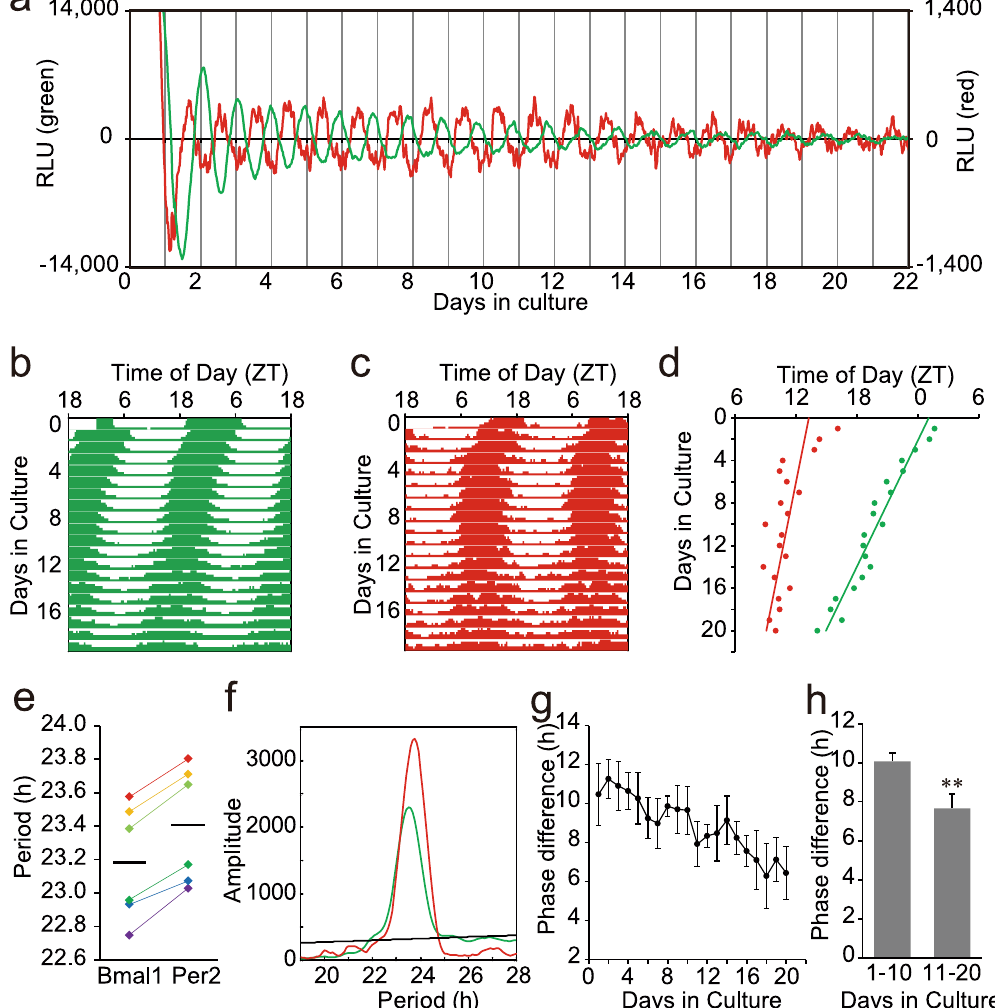
Figure 1. Circadian rhythms in the neonatal SCN slices of Bmal1-Eluc:Per2-SLR2 mice ( a ) Sequential records of circadian Bmal1 (green) and Per2 (red) rhythm in a neonatal SCN slice. Original records were smoothed by a 5 point (80 minutes) moving average method and detrended by a 24 hour moving subtraction method. The abscissa indicates the day in culture and the ordinate the relative intensity of bioluminescence (right, Bmal1 ; left, Per2 ). Day 0 means the day of slice preparation. ( b , c ) A double plotted circadian Bmal1 ( b ) and Per2 ( c ) rhythm in a raster format. Bioluminescence data of each day were indicated as a percentile to the daily mean. ( d ) Successive plots of circadian peak phases ( Bmal1 , green; Per2 , red) and regressions lines fitted to them in the same SCN slice as used in ( a ). ( e ) Circadian periods of individual Bmal1 and Per2 rhythms (n = 6) calculated from a regression line. A horizontal bar indicates the mean circadian period. Circadian periods of the rhythms from the same SCN are indicated with the same colors. ( f ) Chi-square periodogram demonstrates significantly different circadian periods of Bmal1 (green) and Per2 (red) rhythm. A black oblique line in the graph indicates the significance level at p < 0.05. ( g ) Phase difference ( ψ ) between the circadian Bmal1 and Per2 peaks in each cycle. The values are indicated as the mean and SD. ( h ) The mean and SD of ψ in the first and the last 10 cycles is indicated. ** p < 0.01 (paired